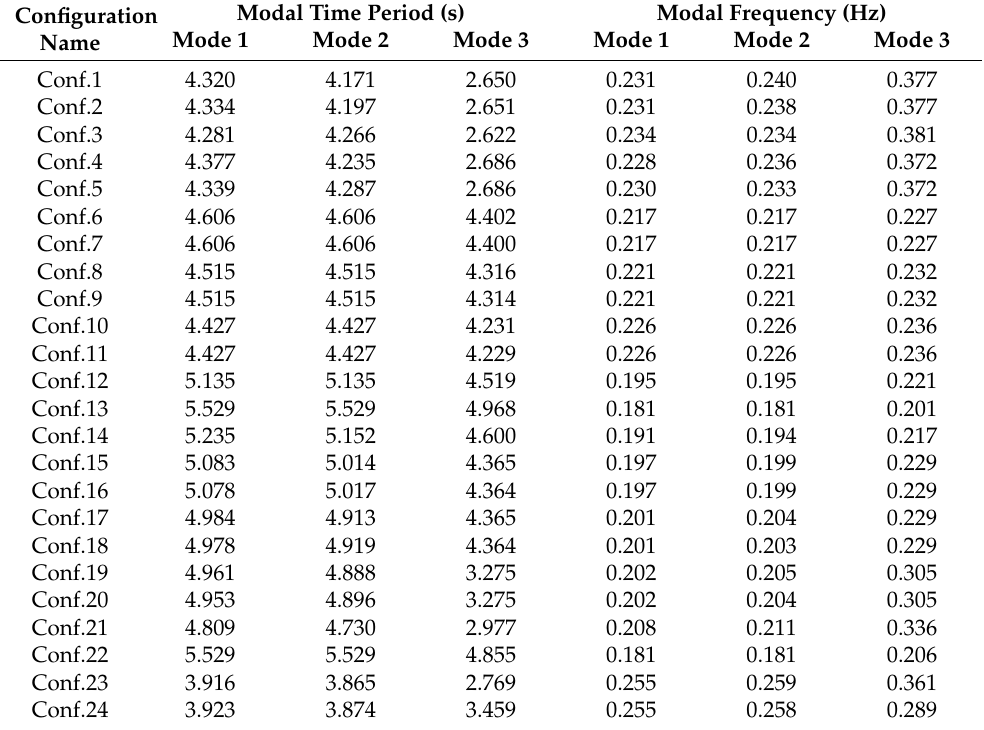
Figure 5. Modal Analysis Results: ( a ) Conf.1 mode 1, ( b ) Conf.1 mode 2, ( c ) Conf.1 mode 3, ( d ) Conf.30 mode 1, ( e ) Conf.30 mode 2, and ( f ) Conf.30 mode 3. Table 4. Fundamental Natural Period .